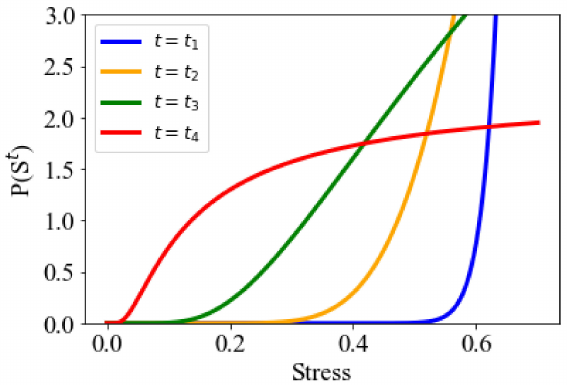
Figure 4. Target distributions of each temperature. The blue line, t = t 1 , is the probability dis- tribution at the lowest temperature. The red line, t = t 4 , is the probability distribution at the highest